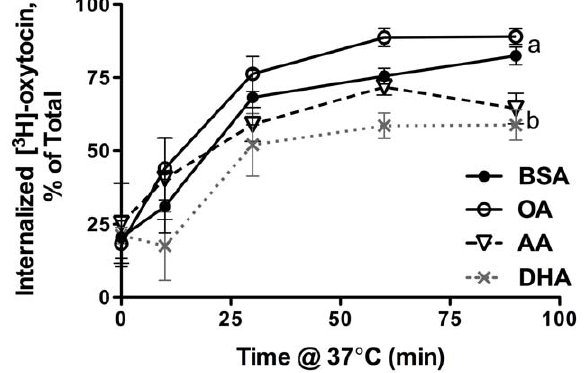
Figure 4. Total inositol phosphates (IPs) generated in response to 100 nM oxytocin in PHM1-41 cells. Data are expressed as a percent increase of total IPs over unstimulated basal. Values are mean 6 SEM (n=4 experiments). Bars not sharing common letters are significantly different between treatment groups, p , 0.05. doi:10.1371/journal.pone.0041708.g004 PLoS ONE |